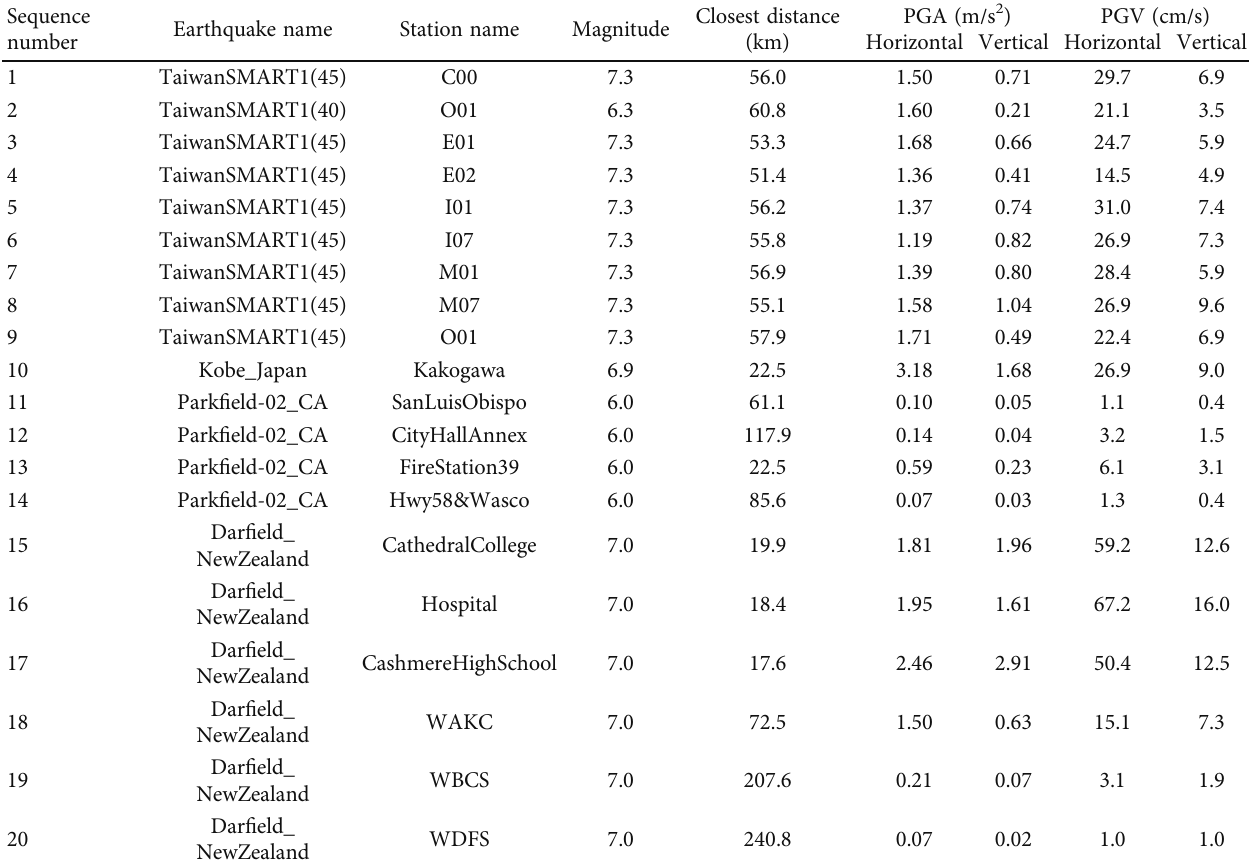
Table 2: List of non-near-fault earthquakes with pulse-like ground